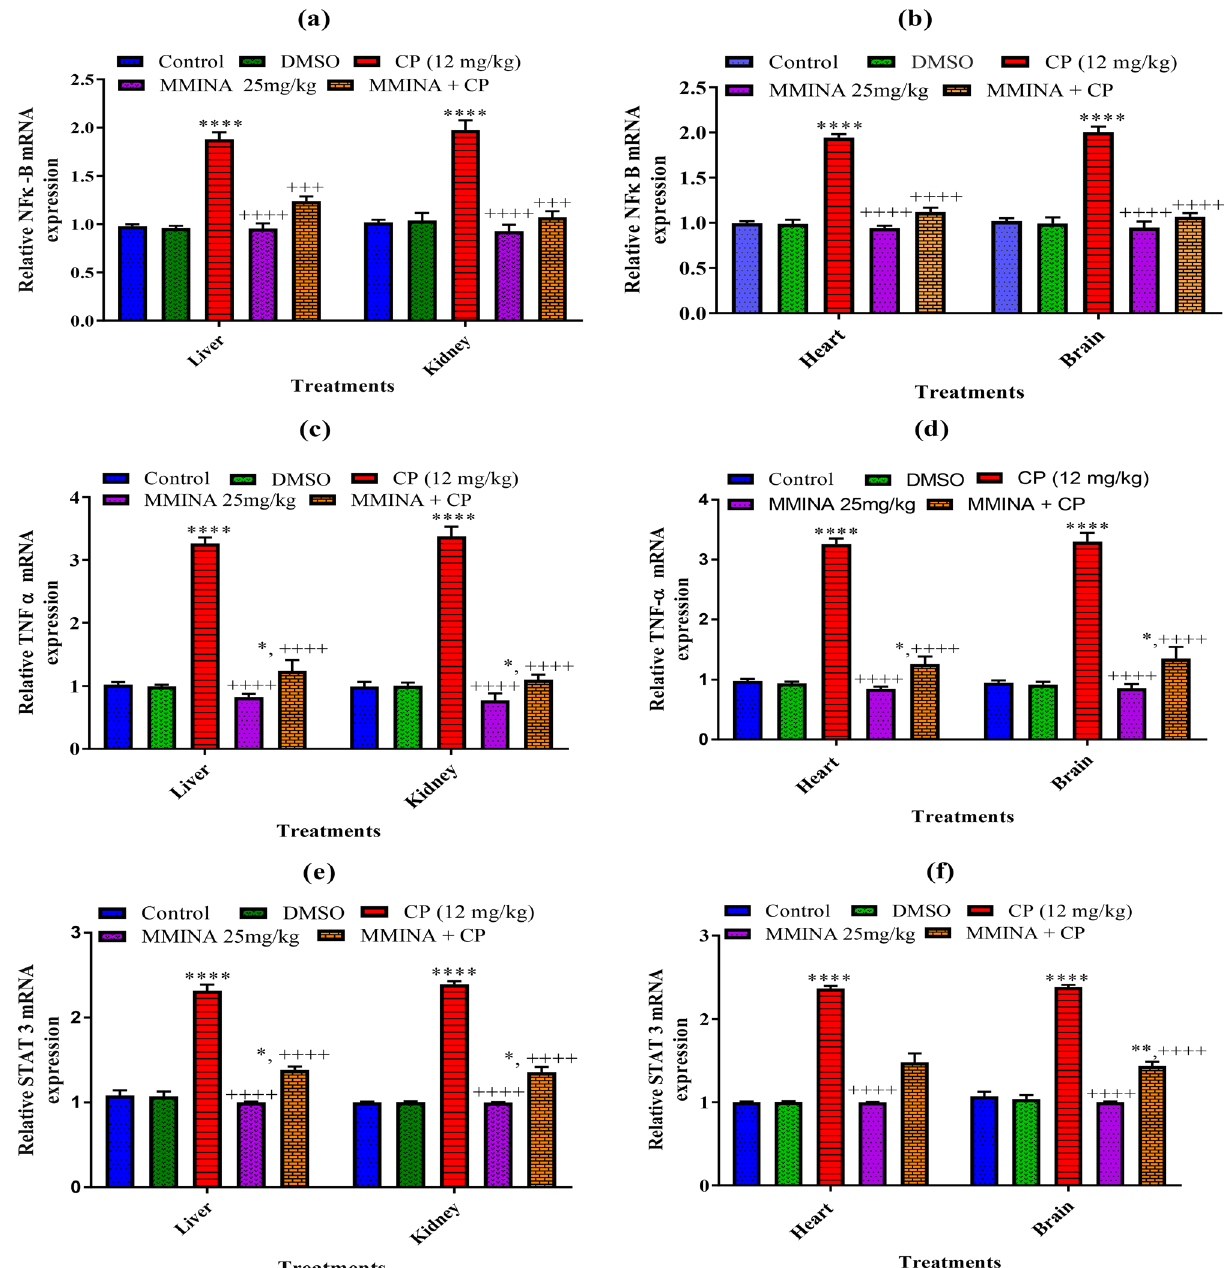
Figure 4. Effect of MMINA treatment on the gene expression of STAT-3, NF-κBp65, TNF-α. mRNA expression was measured by quantitative RT-PCR in the in Liver Kidney, heart and brain tissues. Data are mean ± SEM, (n = 6). *, **** p < 0.05 and p < 0.0001 versus Control respectively, and ++++ p < 0.0001 versus CP. Data analyzed by One-way ANOVA followed by Tukey’s multiple comparison